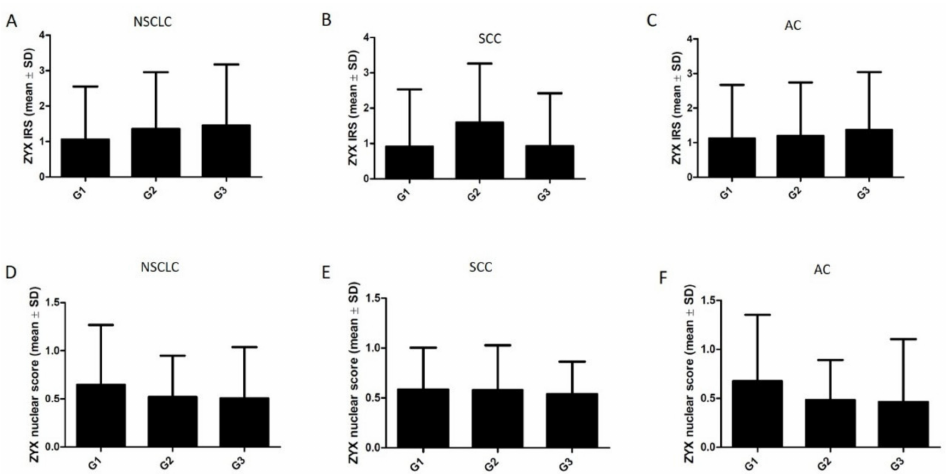
Figure 9. Immunohistochemistry (IRS, nuclear score) of ZYX expression in NSCLC cells in relation to the histological grade. The analysis for NSCLC ( A , D ), lung SCC ( B , E ), and lung AC ( C , F ). Dunn’s multiple comparisons test.